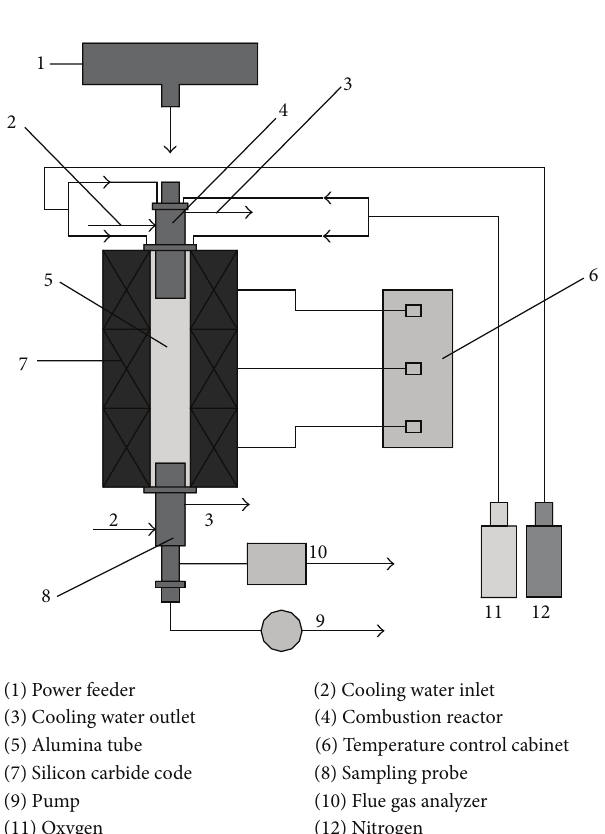
Figure 1: Schematic of the DTF